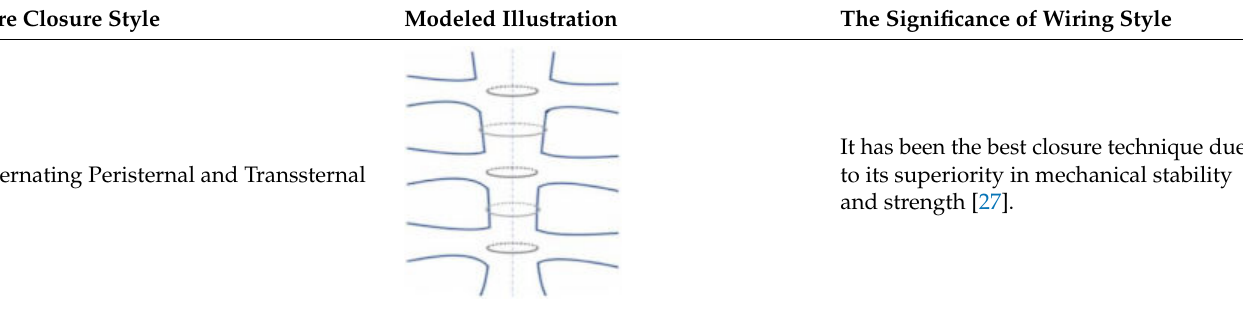
Table 1. Illustration of different wiring closure